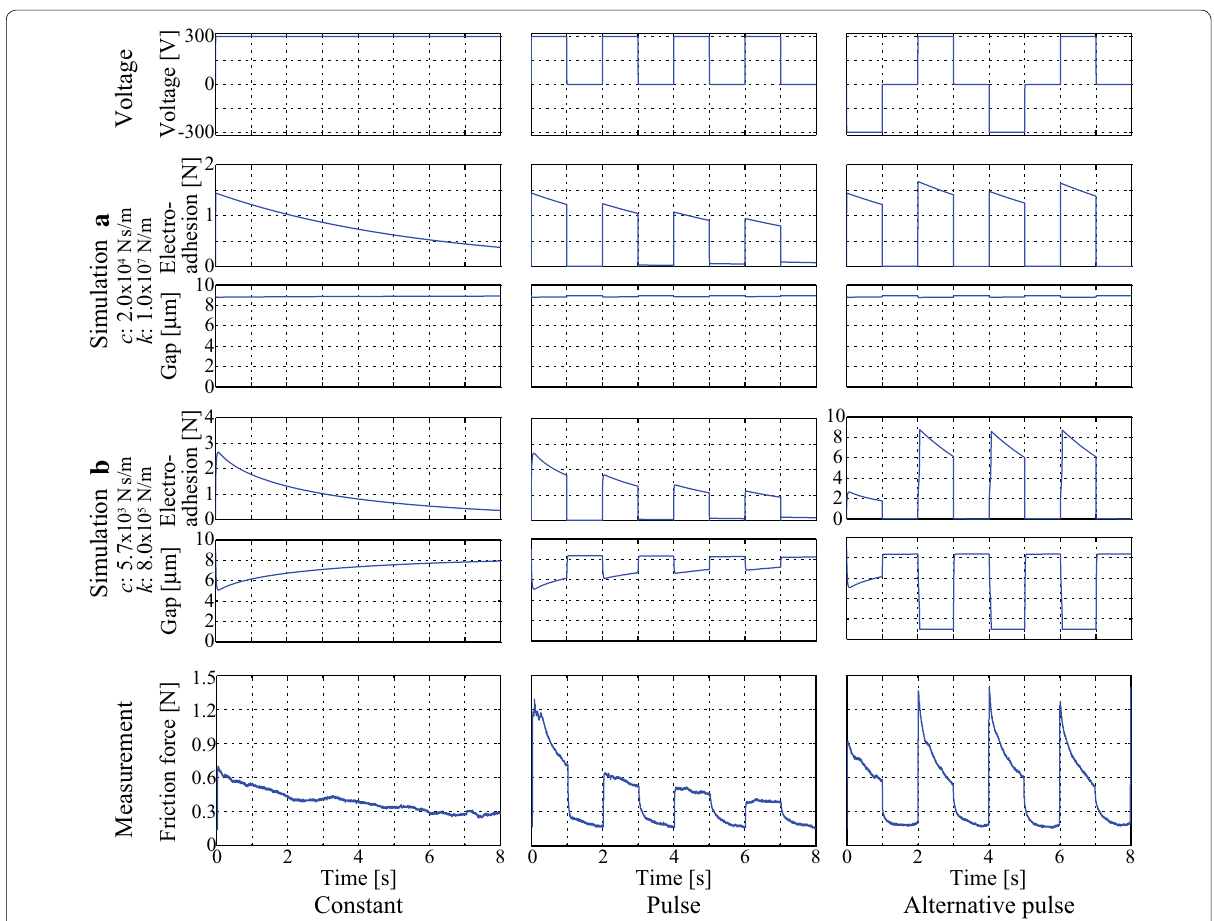
Fig. 4 Comparison of simulations ( a , b ) with friction force measurements. Simulation parameters are ε 1 : 3.1 × ε 0 F / m, ε 2 : 1.0 × ε 0 F / m,